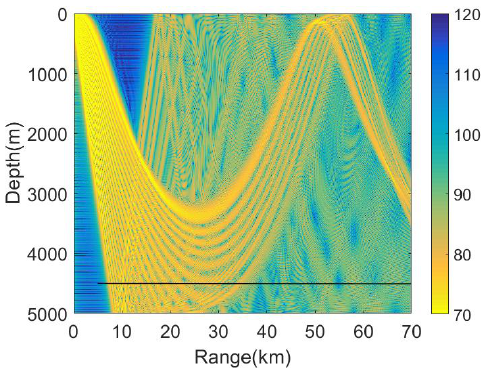
Figure 3. Acoustic intensity from all modes. The solid black line is the trajectory of source moving radially from the hydrophone.